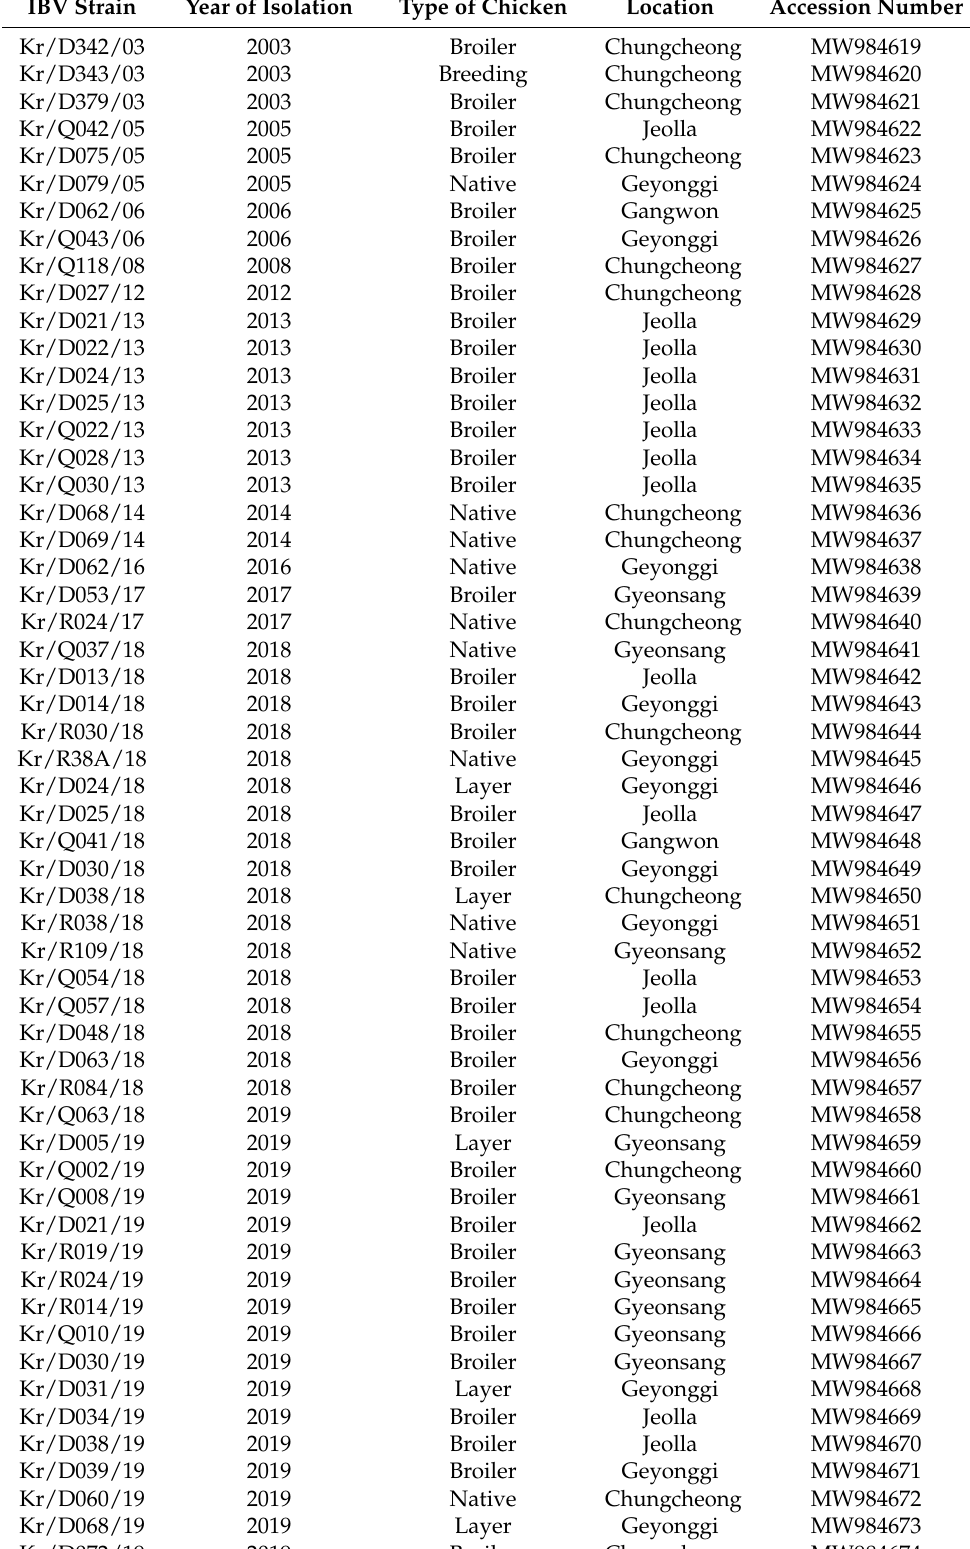
Table 1. Korean IBV isolates analyzed in this